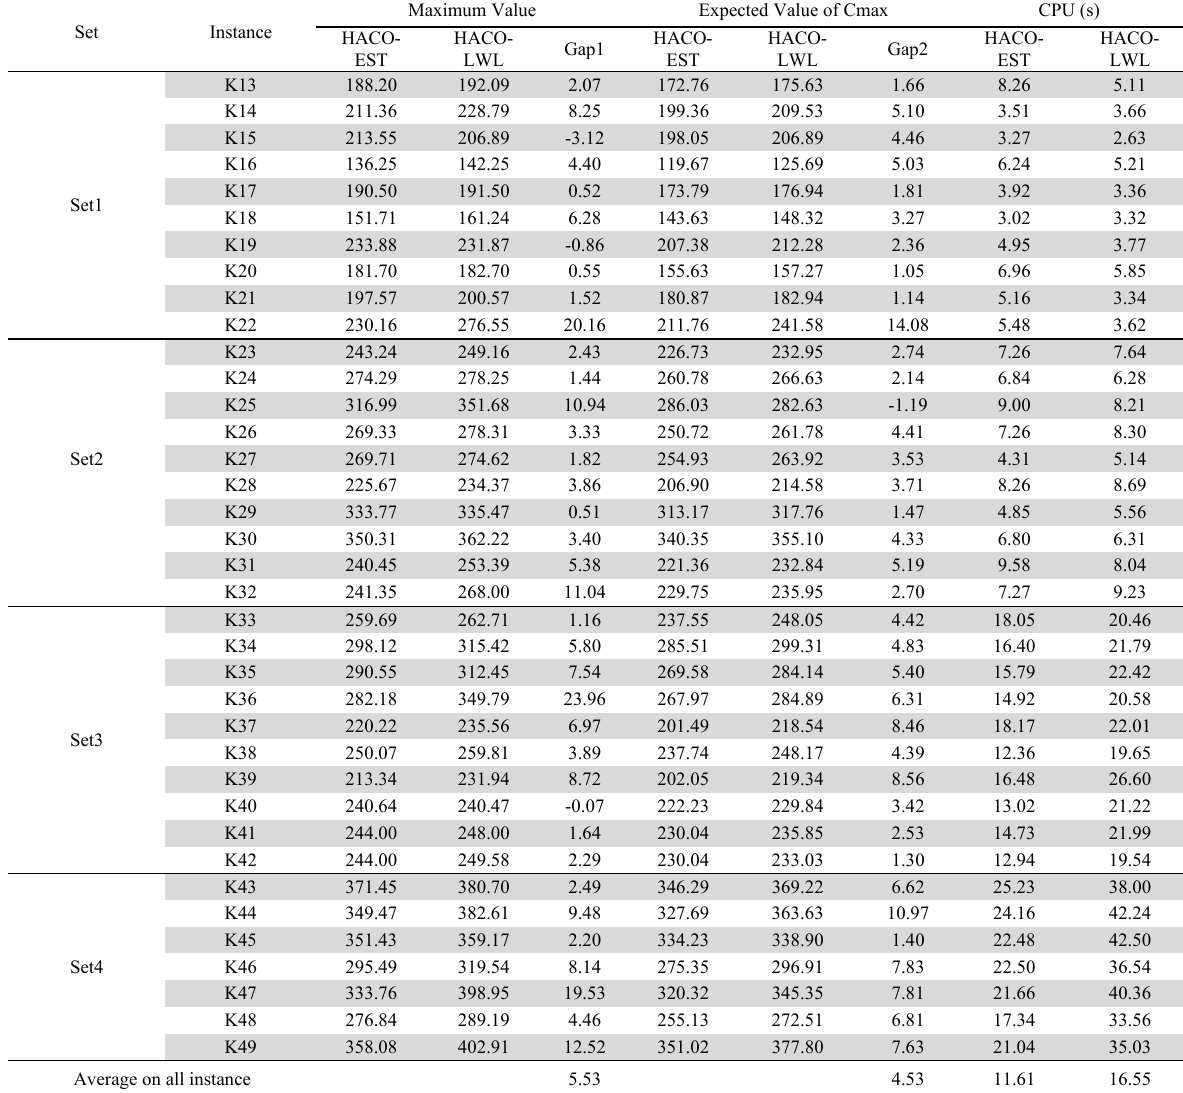
Detailed SO approach results using EST and LWL